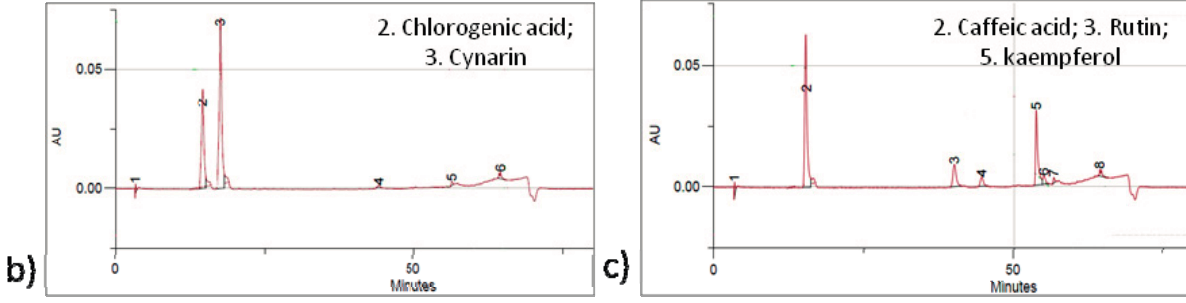
Figure 2. ( a ) Chromatogram obtained by high perfomance liquid chromatography-diode array detector (320 nm) of methanol extract of PER02 landrace. 1 : Chlorogenic acid (Rt = 14.95 min), 2 : Caffeic acid (Rt = 15.18 min), 3 : 3,5-di- O -caffeoylquinic acid (Rt = 33.86 min), 4 : 1,5-di- O -caffeoylquinic acid (Rt = 35.60 min), 5 : Rutin (Rt = 39.68 min), 6 : 4,5-di- O -caffeoylquinic acid (Rt = 41.29 min); ( b ) HPLC chromatogram (320 nm) of the standards: chlorogenic acid (Rt = 14.72 min) and cynarin (Rt = 17.62 min); ( c ) HPLC chromatogram (320 nm) of the standards caffeic acid (Rt = 15.31 min), rutin (Rt = 39.59 min) and kaempferol (Rt = 53.38